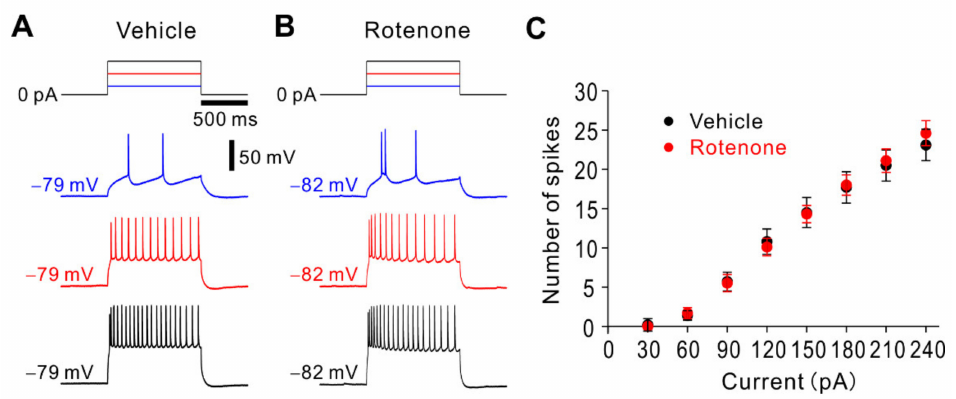
Figure 5. Effects of intranasal administration of rotenone on spike firing properties of layer V pyramidal neurons. ( A , B ) Representative spike firings obtained from vehicle-treated mice ( A ) and rotenone-treated mice ( B ). Spike firings were evoked by current injection at 60 pA (blue traces), 150 pA (red traces) and 240 pA (red traces), respectively. ( C ) Relationship between the injected current intensity and number of spikes obtained from vehicle-treated mice ( n = 16) and rotenone- treated mice ( n =